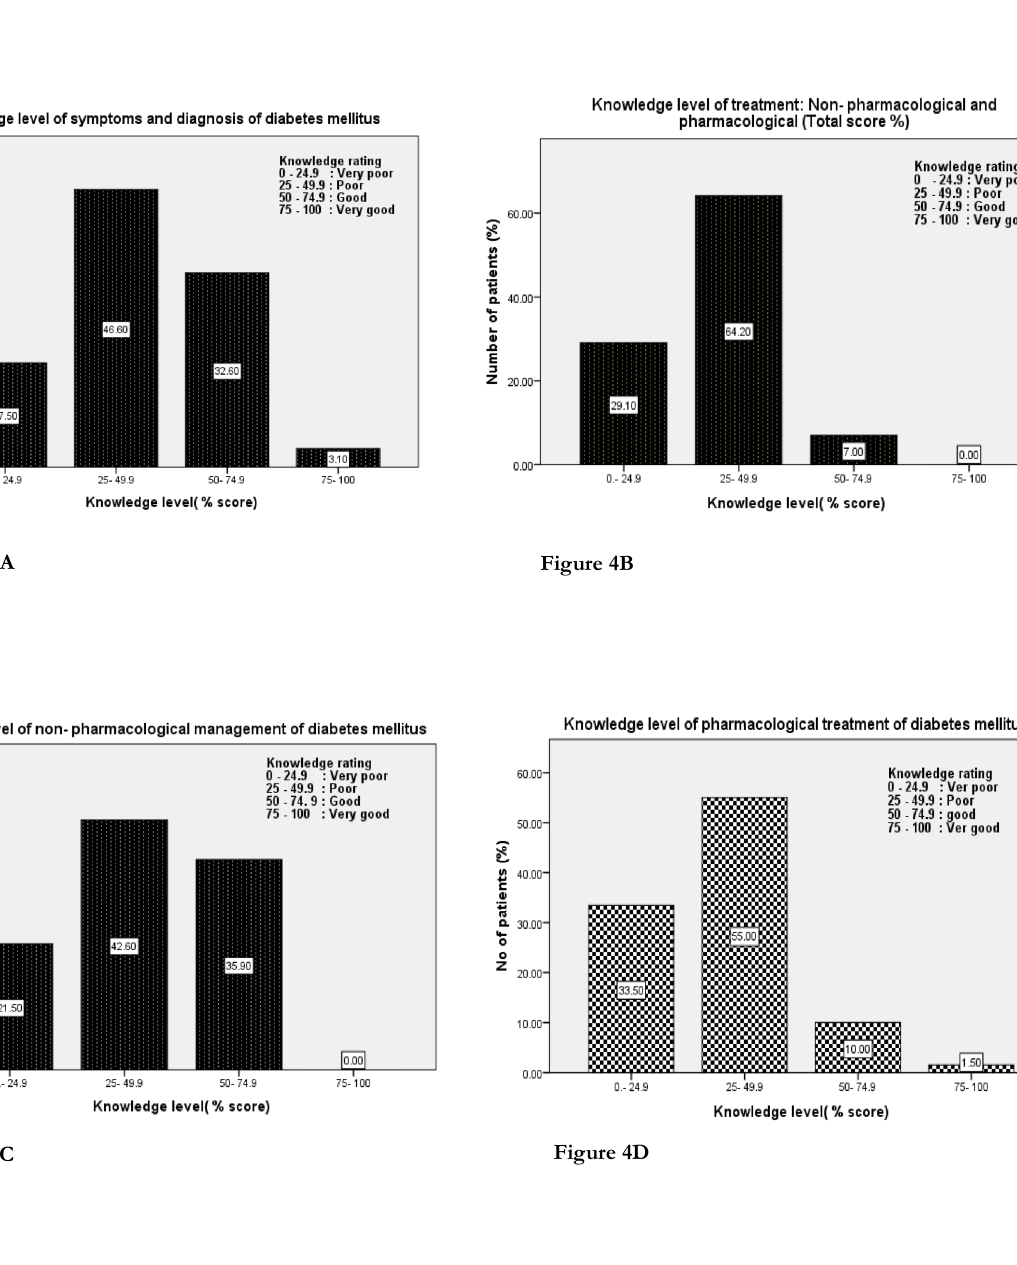
Sri Lanka Journal of Diabetes, Endocrinology and